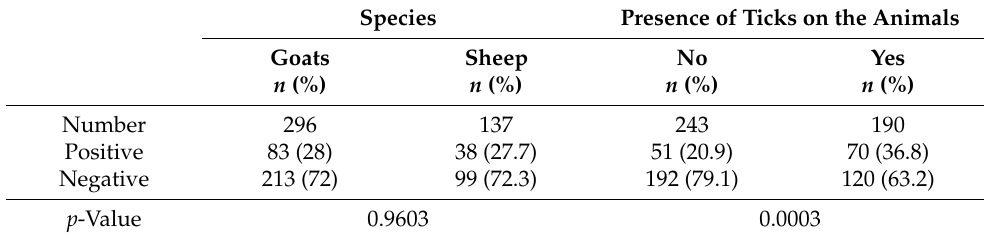
Table 3. Association of the frequency (16S rRNA PCR) of Anaplasma phagocytophilum and related variants in small ruminants with species and tick